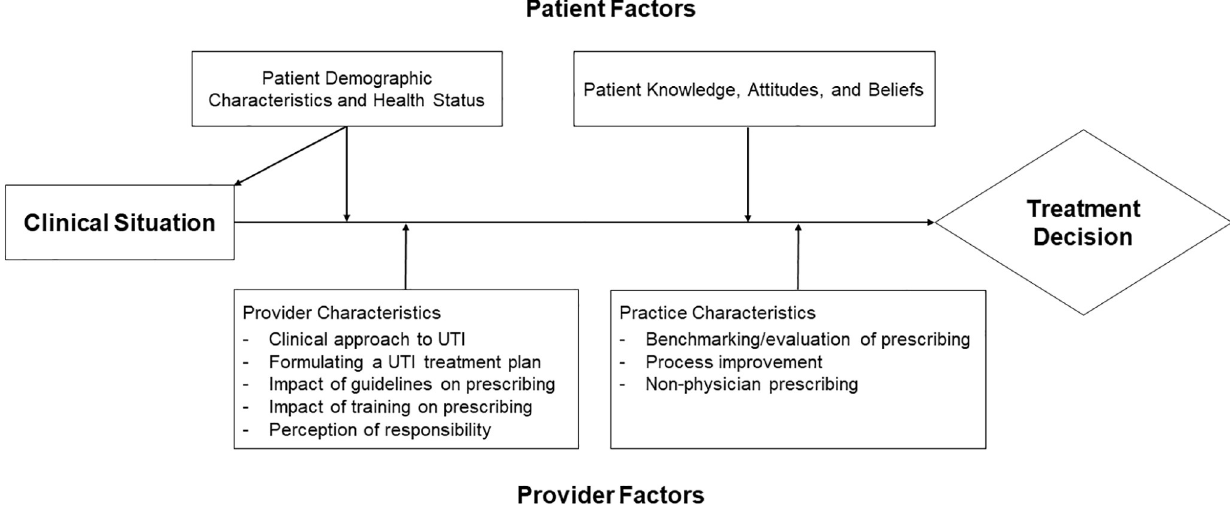
Fig 1. Conceptual model for prescribing decisions for